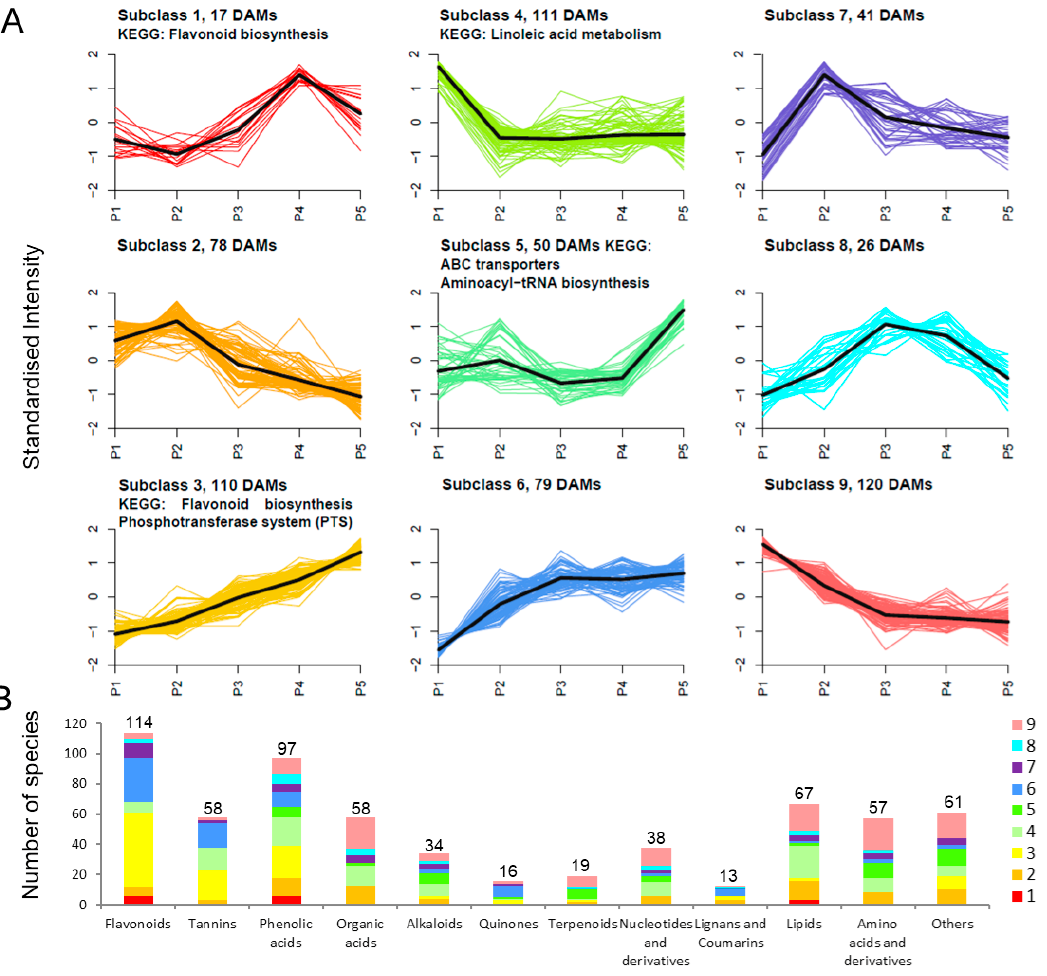
Figure 4. K-means diagram of differential metabolites and classification statistics. ( A ) Clustered DAM profiles in developing endopleura. The clusters were defined on the basis of metabolite content profile using the k-means method in R. ( B ) Quantity statistics based on metabolite species. The colors come from the classification of the